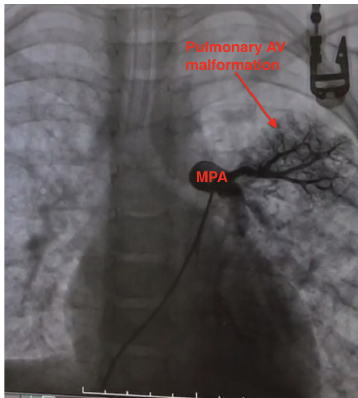
Figure 2: TEE revealing cor triatriatum having two fenestrations: one with a width of 2 mm and the other with 3 mm diameter.